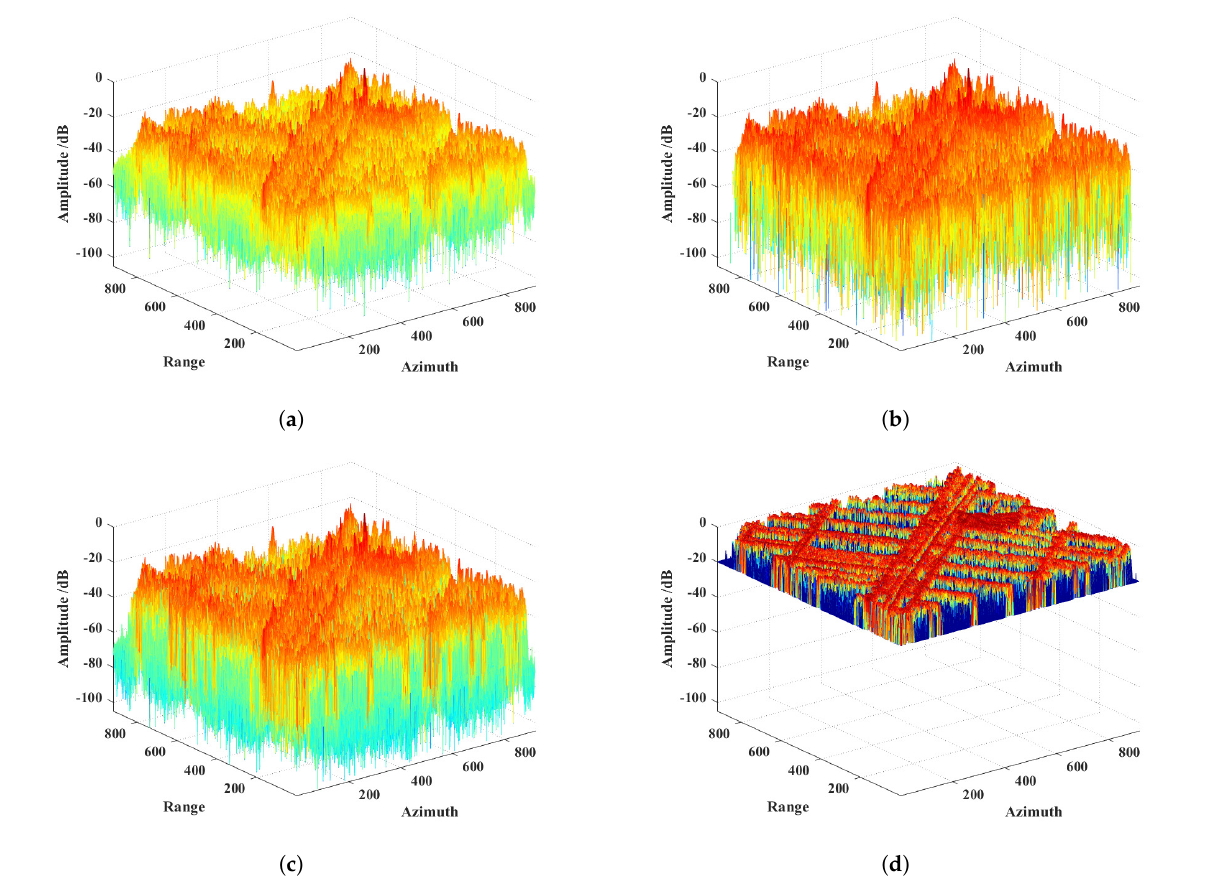
Figure 2. Images restored by different methods: ( a ) MF; ( b ) ˆX B of BiIST; ( c ) ˜X B of BiIST; ( d ) Amplitude deviation between ( c ) and ( a ).